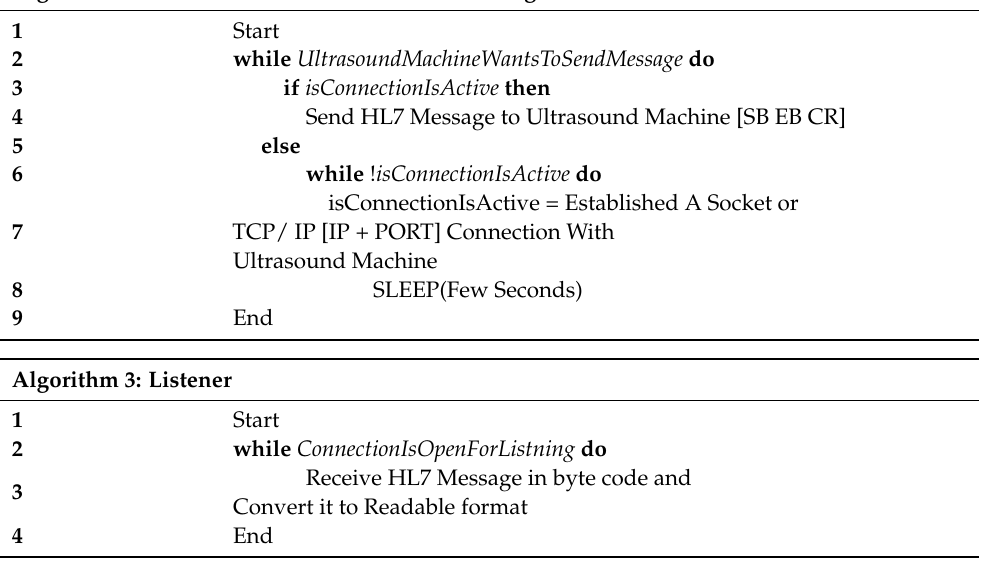
Algorithm 2: RSPI3 to Ultrasound Machine Message